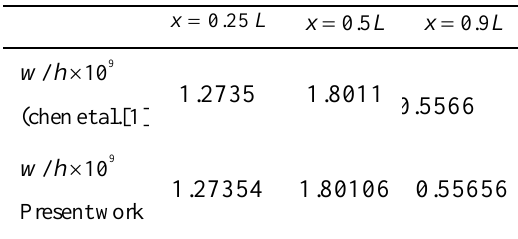
Table 1. Comparison between the results of present work and the obtained results by Chen et al. [1]